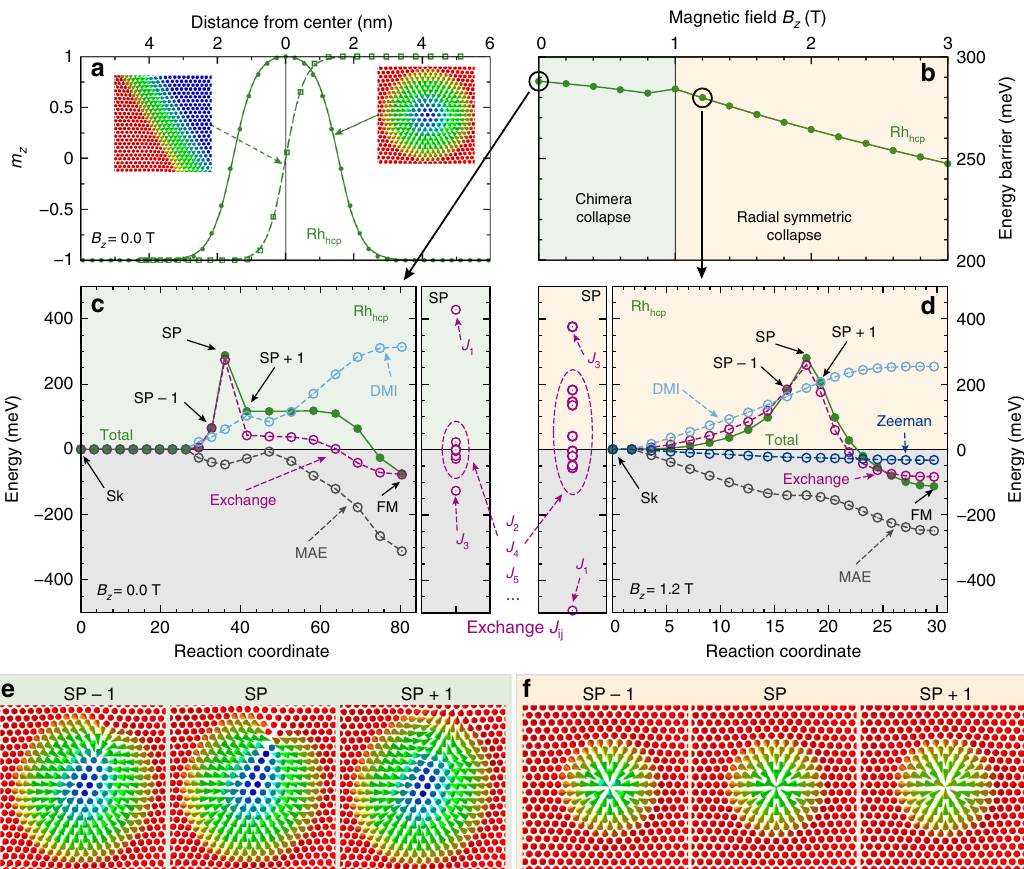
Fig. 5 Pro fi le and stability of skyrmions in Rh/Co/Ir(111). a Domain wall pro fi le (open symbols) and zero fi eld skyrmion pro fi le ( fi lled symbols), i.e., z -component m z of the local magnetic moment, obtained based on atomistic spin dynamics for Rh hcp /Co/Ir(111). The dashed and solid lines are standard domain wall and skyrmion pro fi le 57 , respectively. Note that there are small deviations in both cases due to the exchange frustration. The insets show the domain wall and skyrmion spin structures on the two-dimensional atomic lattice. b Energy barrier protecting skyrmions in Rh hcp /Co/Ir(111) against annihilation into the FM state as a function of applied magnetic fi eld. The cross-over from the chimera collapse (green background) to the radial symmetric collapse (beige background) at 1 T is indicated. c Total energy and energy contributions for the chimera collapse from the different interactions (exchange, DMI, magneto-crystalline anisotropy energy (MAE)) at zero fi eld versus the reaction coordinate along the minimum energy path from the initial isolated skyrmion (Sk) state to the fi nal FM state for Rh hcp /Co/Ir(111). Energies are summed over all atoms of the simulation box and are given relative to the energy of the isolated skyrmion state. The saddle point (SP) is indicated. To the right: exchange energy at the saddle point, E SP , resolved with respect to the exchange interactions of different shells: J 1..10 . d the same plot as in c for the radial symmetric collapse mechanism at a fi eld of B = 1.2 T. e Images along the minimum energy path in c right before the SP (SP-1), at the SP, and just after the SP (SP + 1). For all images of the minimum energy path see Supplementary Fig. 8. f Images along the minimum energy path in d for the radial symmetric collapse mechanism. Note that in e, f only a small part of the full simulation box which contained (70 × 70) spins is